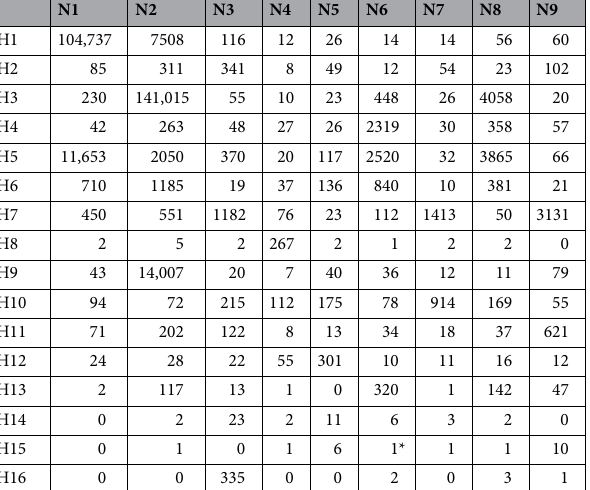
Table 1. GISAID submitted HA and NA sequences from avian, mammalian and human hosts. Sequence data were accessed in Nov 2022. *Sequence information retrieved from the Influenza Virus Database (https://